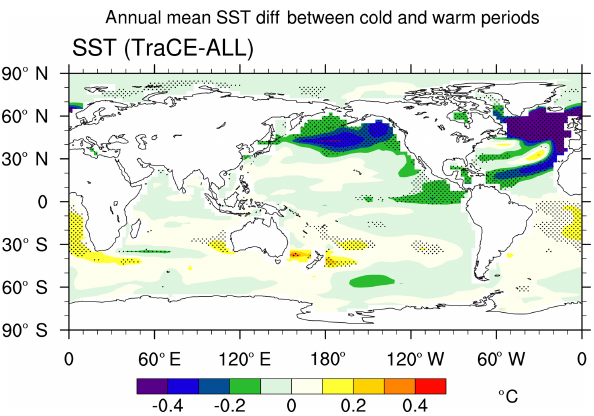
Figure 4. Spatial distribution of annual mean SST difference be- tween the cold and warm periods derived from the TraCE-ALL run. Those regions which were significant above the 95% confidence level are